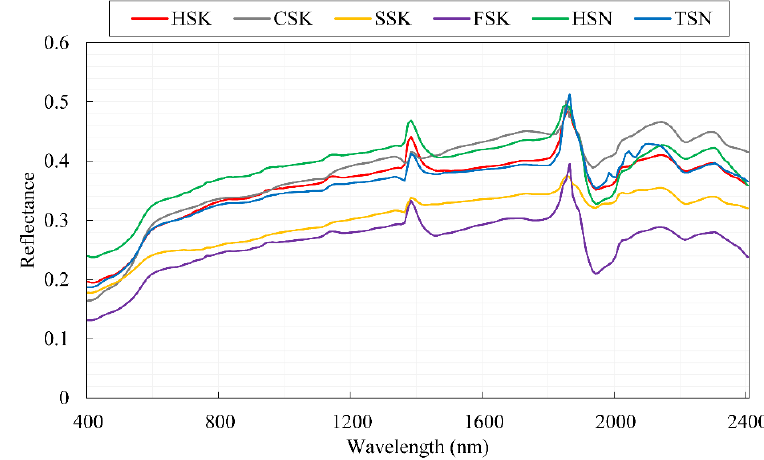
Figure 3. Mean spectral reflectance of various salinized soil types.